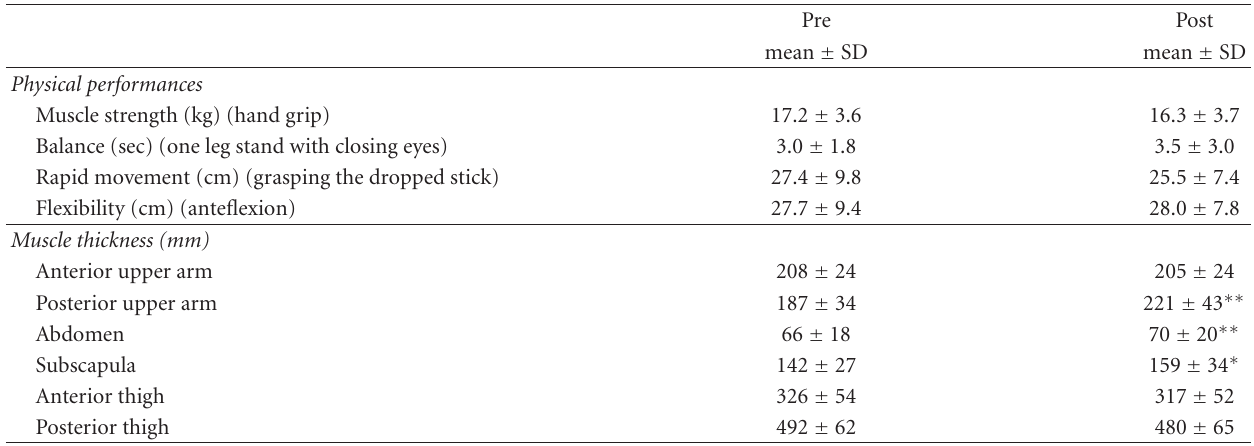
Table 2: Changes in physical performance and muscle thickness pre- and post exercise training in elderly women ( n = 21).